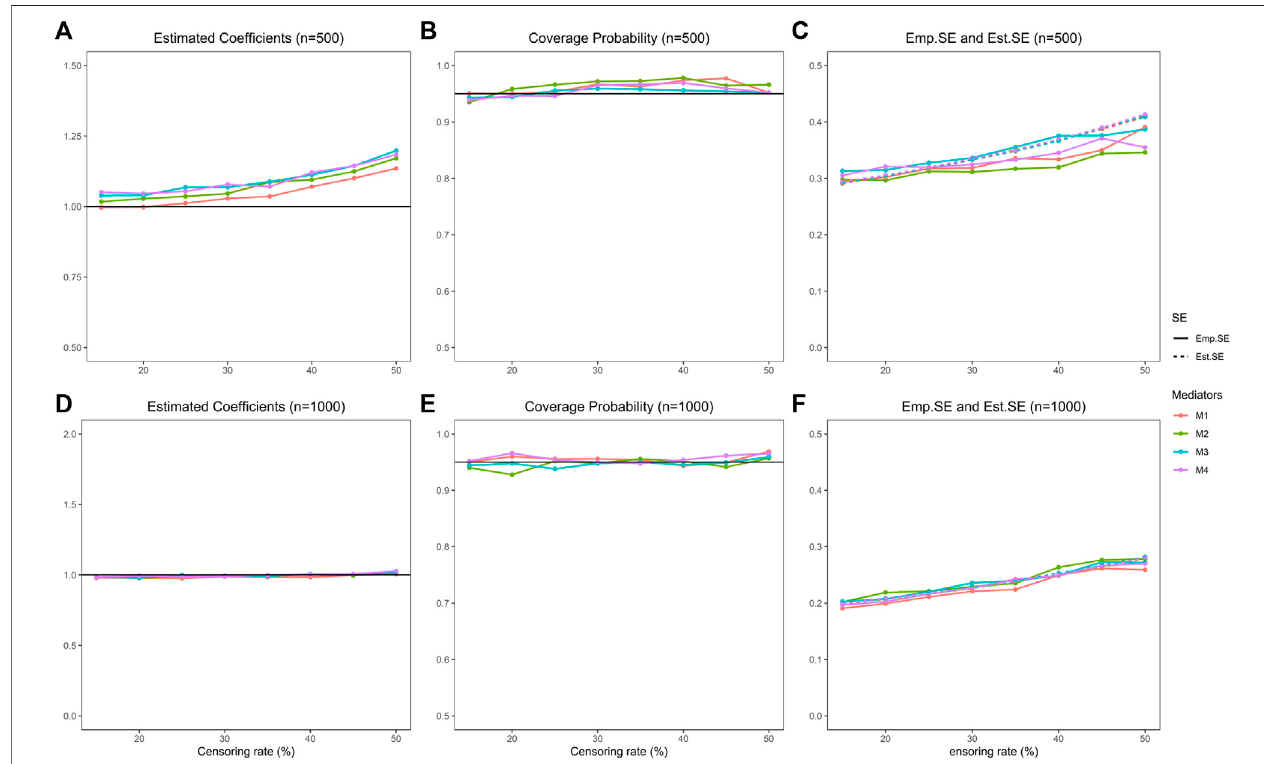
FIGURE4| Indirecteffectestimationoftheproposedprocedure. (A) istheestimatedcoef fi cientsoffourmediatorswithsamplesize500insimulationstudies, (B) is the coverage probability offour mediatorswith sample size500, (C) isthe empirical standard errorand estimated standard error offour mediators with samplesize 500. (D) , (E) , (F) represent the same simulation results as (A) , (B) , (C) correspondingly with sample size 1000.